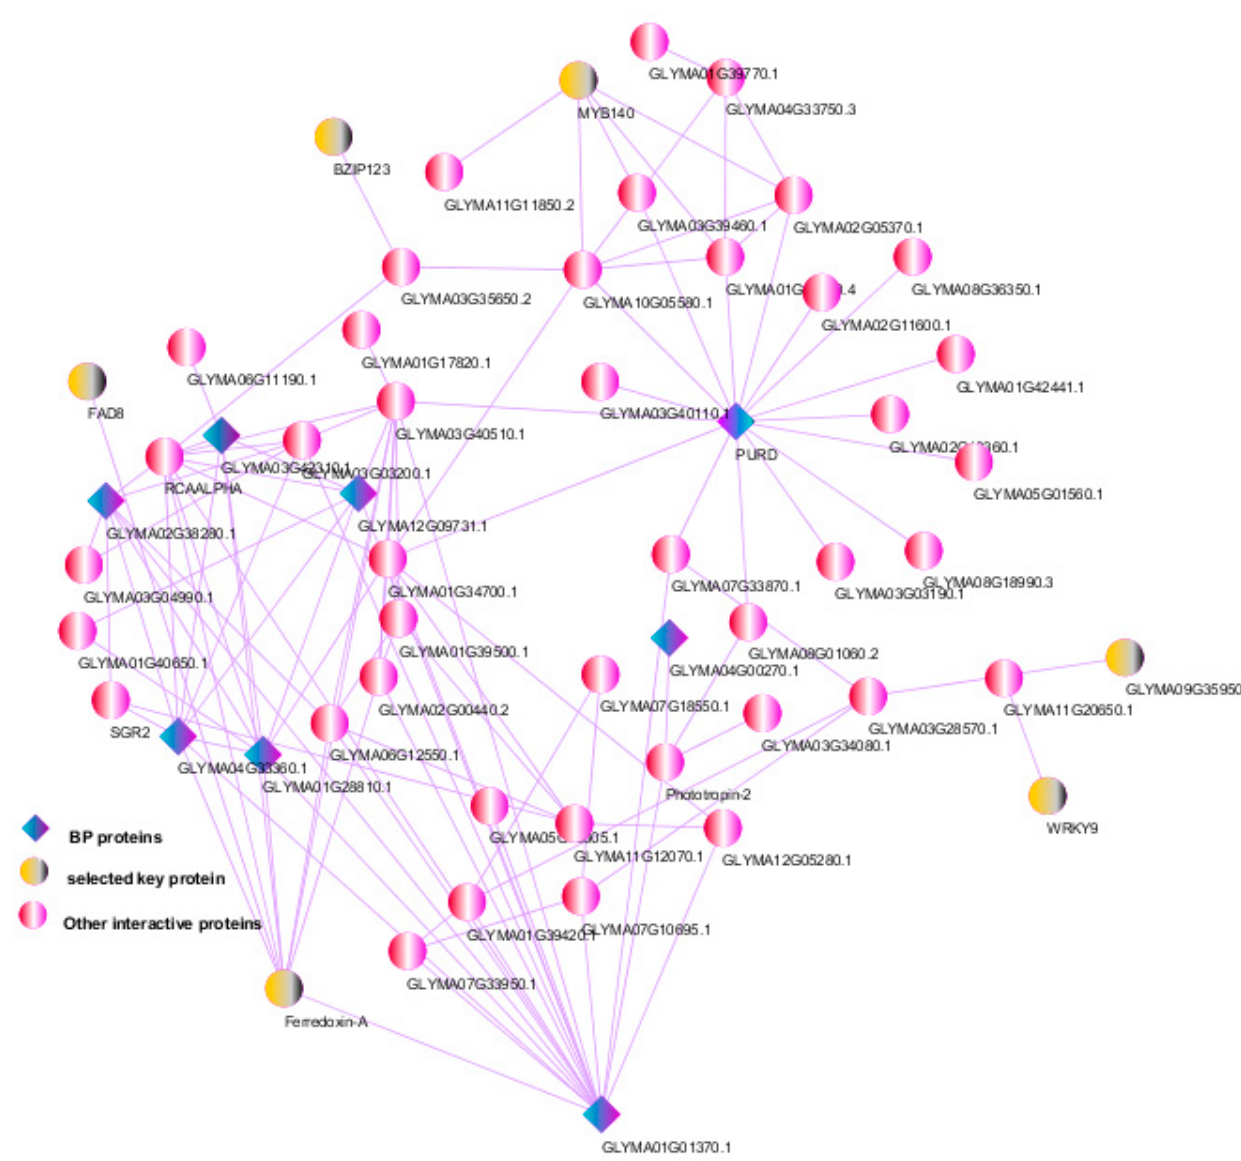
Figure 7. A protein–protein interaction network highlighting the hub genes involved in drought stresses in soybeans. The most significant hubs are ranked based on their importance in the network. The yellow nodes represent the selected key genes, while the turquoise nodes represent the significant biological functions in the network.